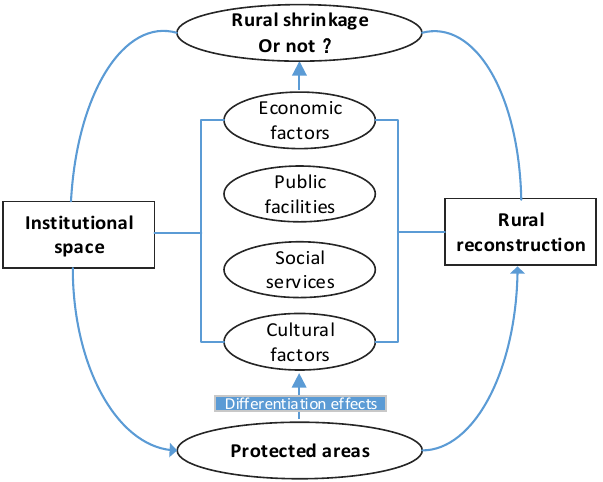
Figure 1. Rural shrinkage and rural reconstruction guided by protected land